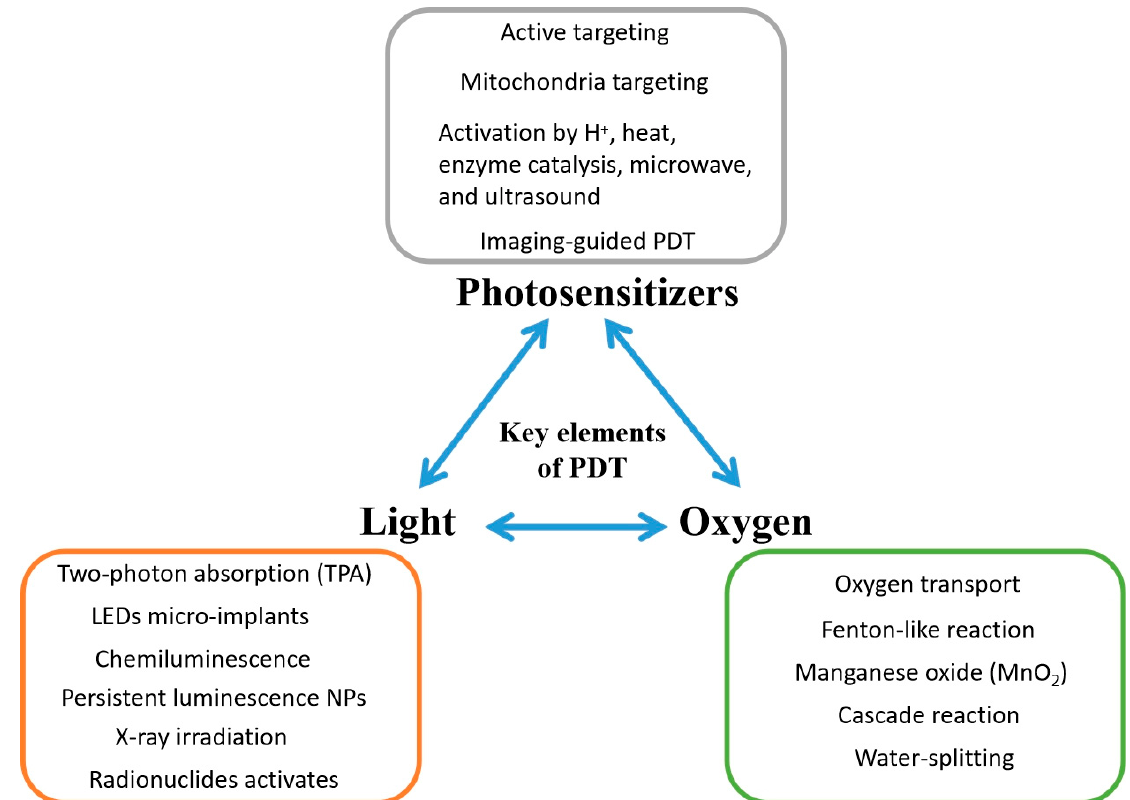
Figure 2. Strategies for improving photodynamic therapy with nanoparticles. NPs: Nanoparticles.